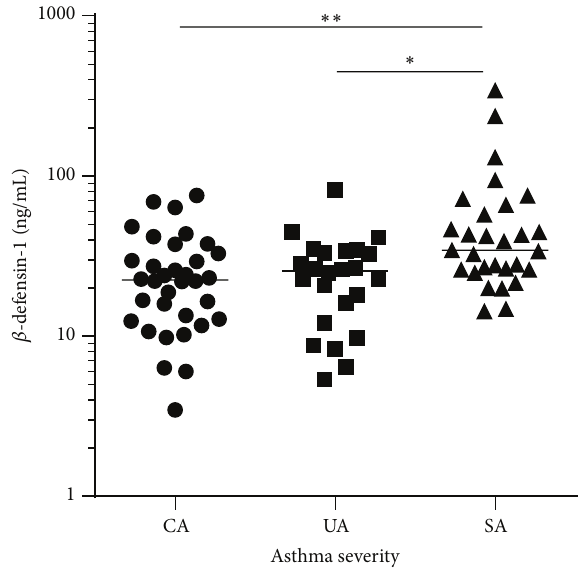
Figure 3: 𝛽 -defensin-1 and asthma severity. The airway expression of 𝛽 -defensin-1 protein is higher in severe asthma (SA; 𝑛 = 29 ) compared with controlled asthma (CA, 𝑛 = 34 ) and uncontrolled asthma (UA, 𝑛 = 24 ) (Kruskal-Wallis test; 𝑝 = 0.002 ). The bars represent the median of each group. ∗ Dunn’s post hoc testing 𝑝 = 0.003 versus controlled asthma. ∗∗ Dunn’s post hoc testing 𝑝 = 0.015 versus uncontrolled asthma.